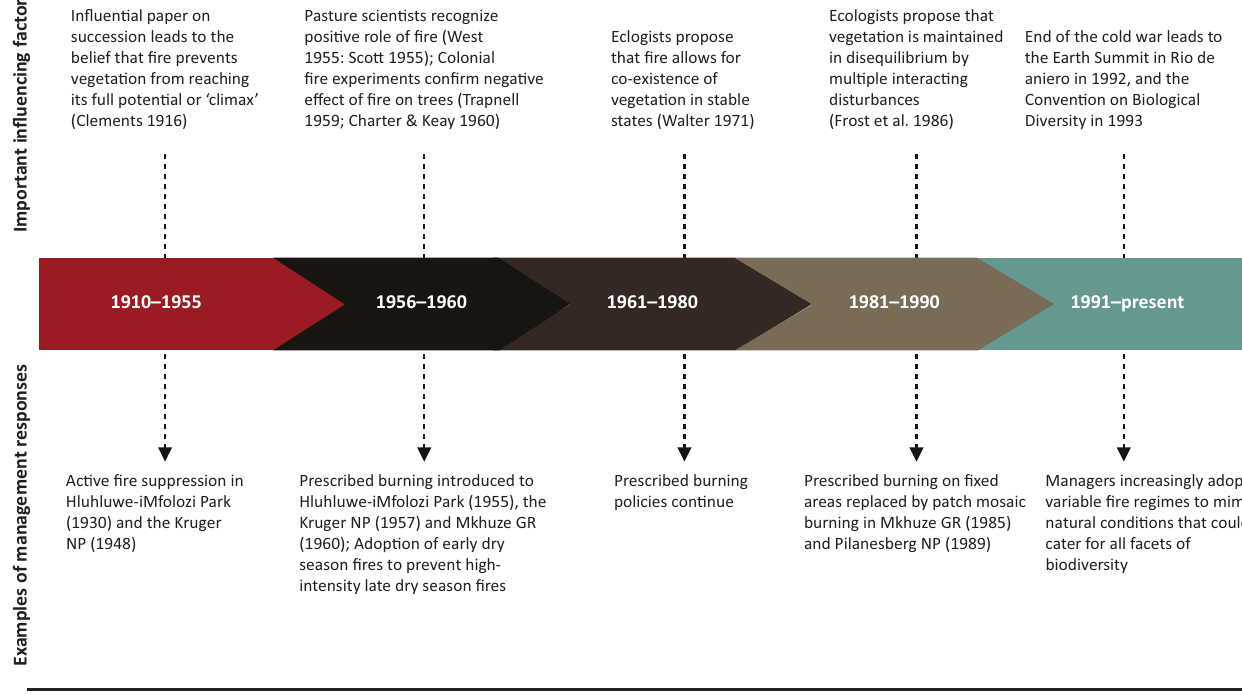
FIGURE 3: Examples of factors that influenced changes in fire management policies and management responses in selected African savanna-protected areas over the past 100 years.